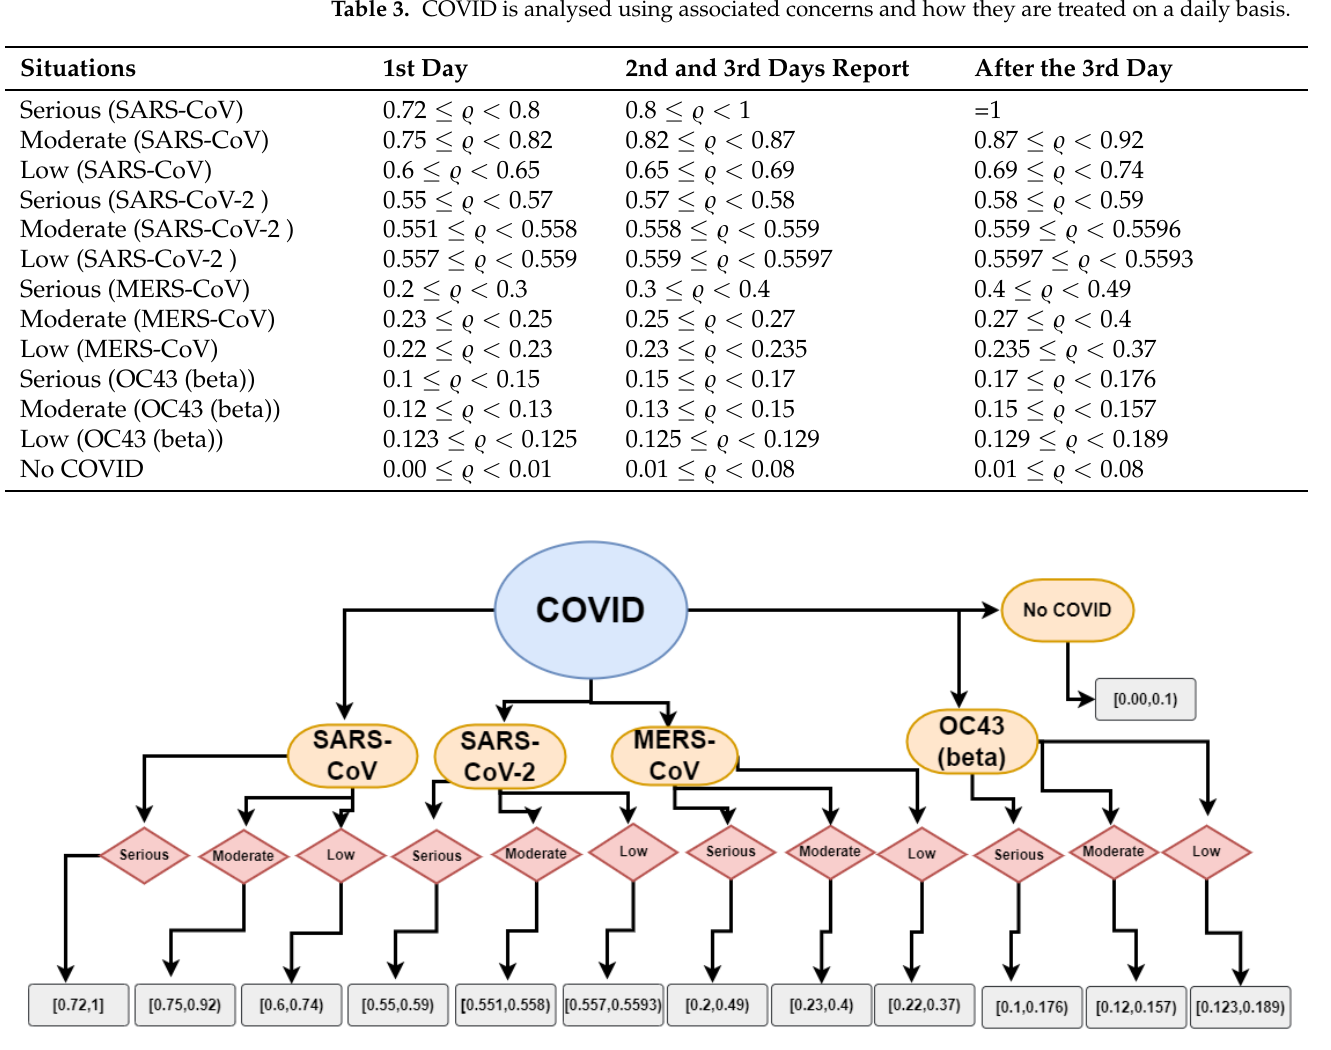
Table 3. COVID is analysed using associated concerns and how they are treated on a daily basis.